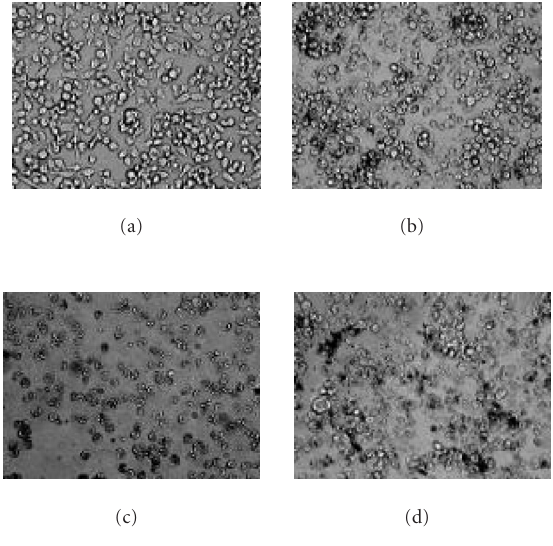
Figure 7. Incidence of apoptotic 4T1 cells as detected through mitochondrial membrane potential disruption assay. Stars indi- cate statistical di ff erence (chi-square) from the untreated group ( P < . 05). Statistical di ff erence among the time periods is indicated by crosses. Diamonds demonstrate statistical di ff er- ence between tamoxifen (5 µ g/mL) and anastrozole (50 µ g/mL), camptothecin (3 . 5 µ g/mL), and the combination (50+5 µ g/mL) whereas squares indicate statistical di ff erence among anastro- zole, camptothecin, and the combination. Bars indicate ± 1